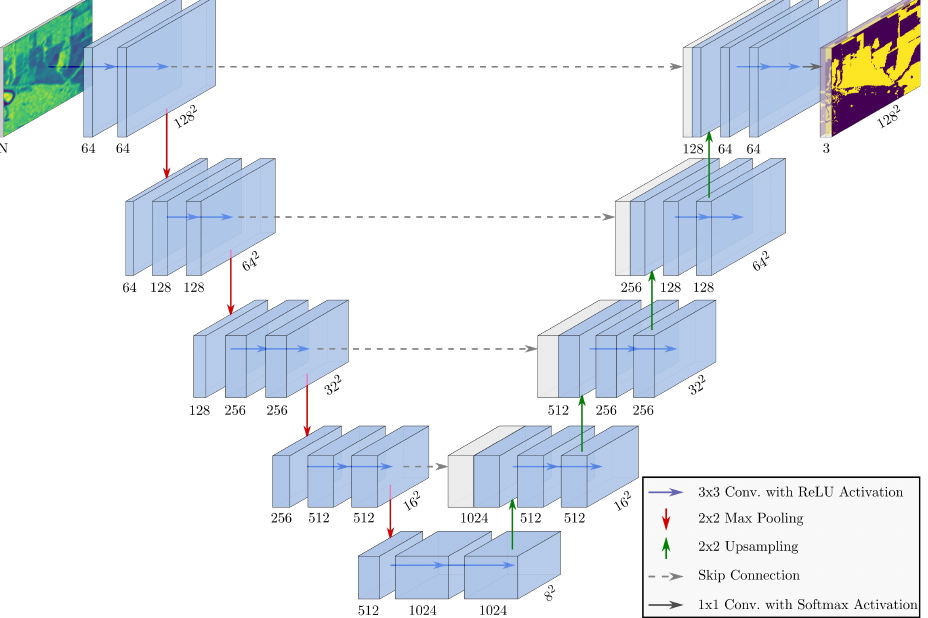
Figure 6. U-Net-like architecture proposed for mapping the Amazon